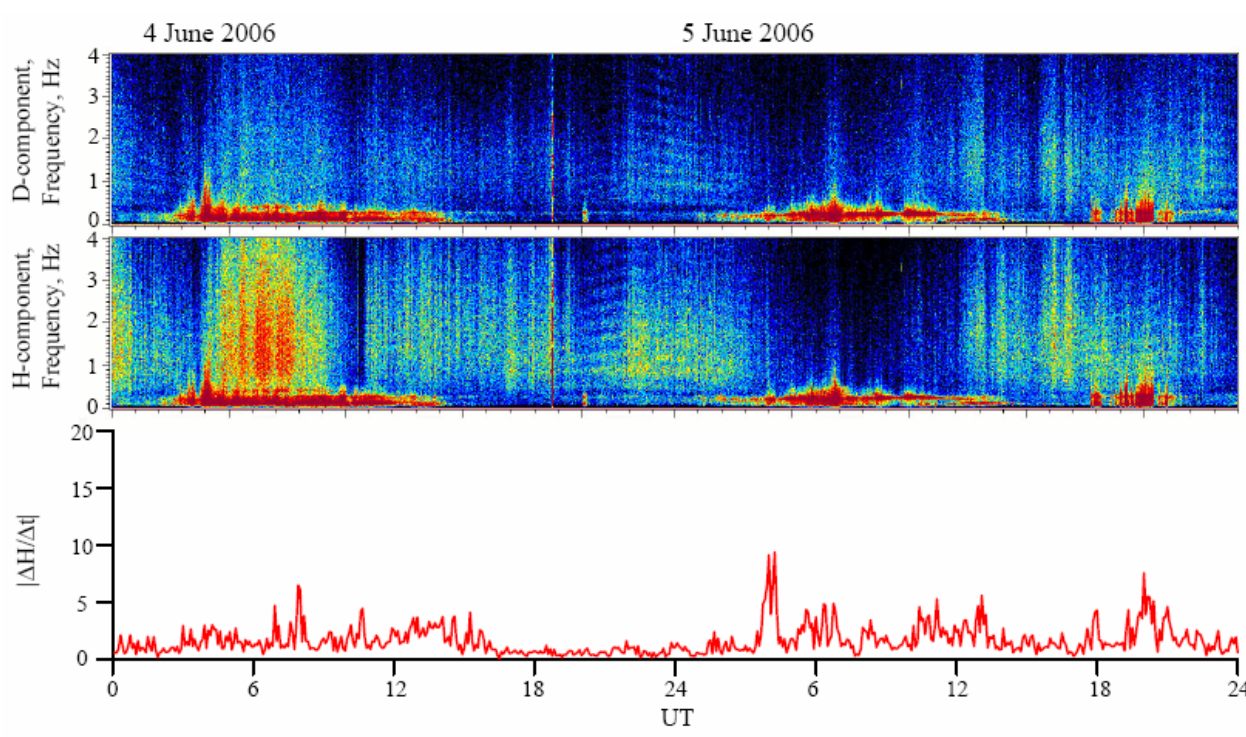
Fig. 1. Top: Spectrograms of H and D components of the geomagnetic fluctuations revealed from search coil magnetometer data in Barentsburg during two successive days (4 June 2006 and 5 June 2006). Bottom: Variations of the absolute value of the time derivative of the horizontal magnetic field obtained from the standard magnetometer measurements in Barentsburg for the same time